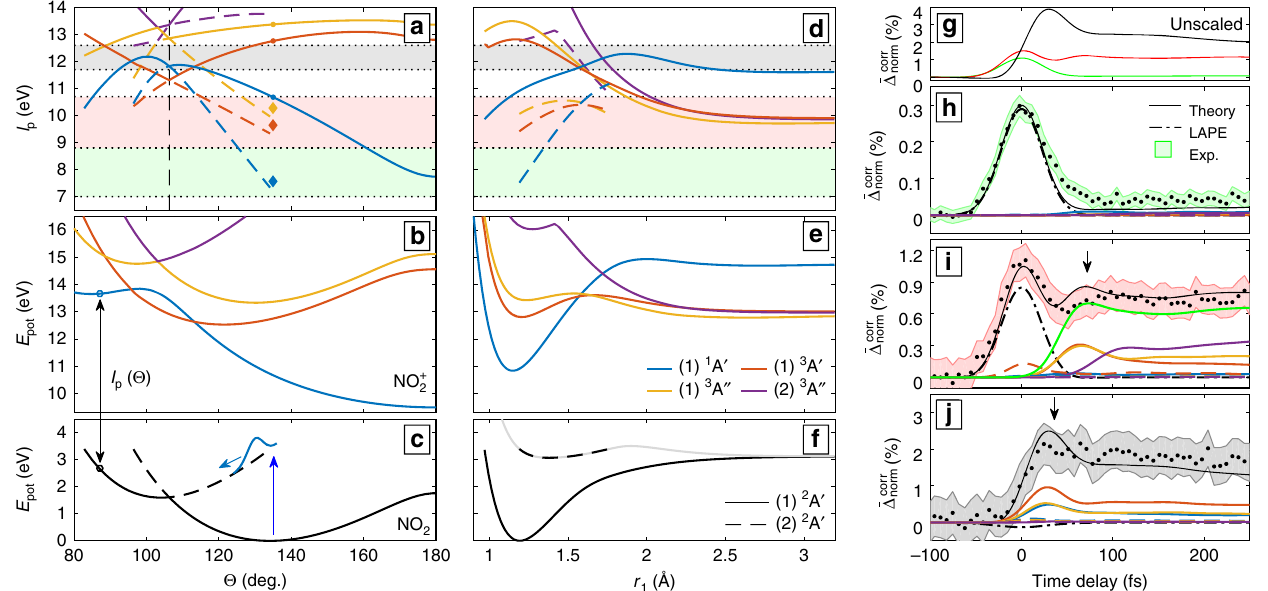
Fig. 5 Quantitative interpretation of the time dependence of three selected photoelectron bands. a – c In fl uence of the bond angle Θ on the local I p , where b , c display the potential energy curves of the neutral states and the cationic states, respectively, and a shows the vertical I p highlighting the selected photoelectron bands (see Fig. 4d). The color code corresponds to b distinguishing transitions from the lower adiabatic state (solid lines) and transitions from the upper adiabatic state (dashed lines). Diamond markers indicate LAPE contributions. The vertical dashed black line in a indicates the CI. d – f show the dependence of the bond distance r 1 . The gray curve in f indicates the complete upper adiabatic state, while the dashed black line emphasizes the accessible part of this state (see text). g Calculated mean band variation (see Fig. 4e). h – j Comparison of experimental data with the rescaled calculated traces. The shaded regions represent the standard deviation of the mean, obtained from 20 consecutive measurements. Contributions from the individual states are displayed using the color code from a , d . The additional green line in i shows the contribution of the three triplet states, i.e., from large amplitude motion, its peak at 72 fs is highlighted by an arrow. The arrow in j indicates the peak contribution of the signal associated with the CI region of the nuclear con fi guration space at 36